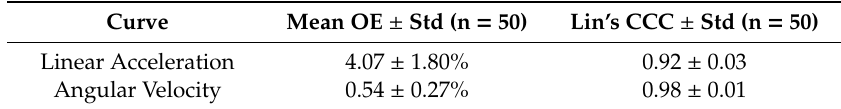
Table 4. Results of the comparison factors between the theoretical and experimental linear acceleration and angular velocity curves (50 trials average).